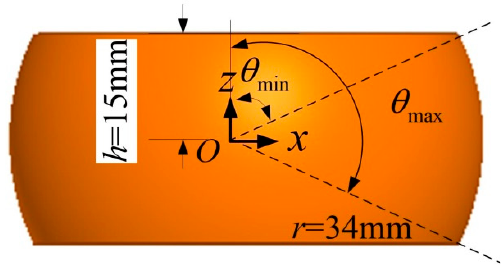
Figure 5. Calculation of geometric angle of rotor.